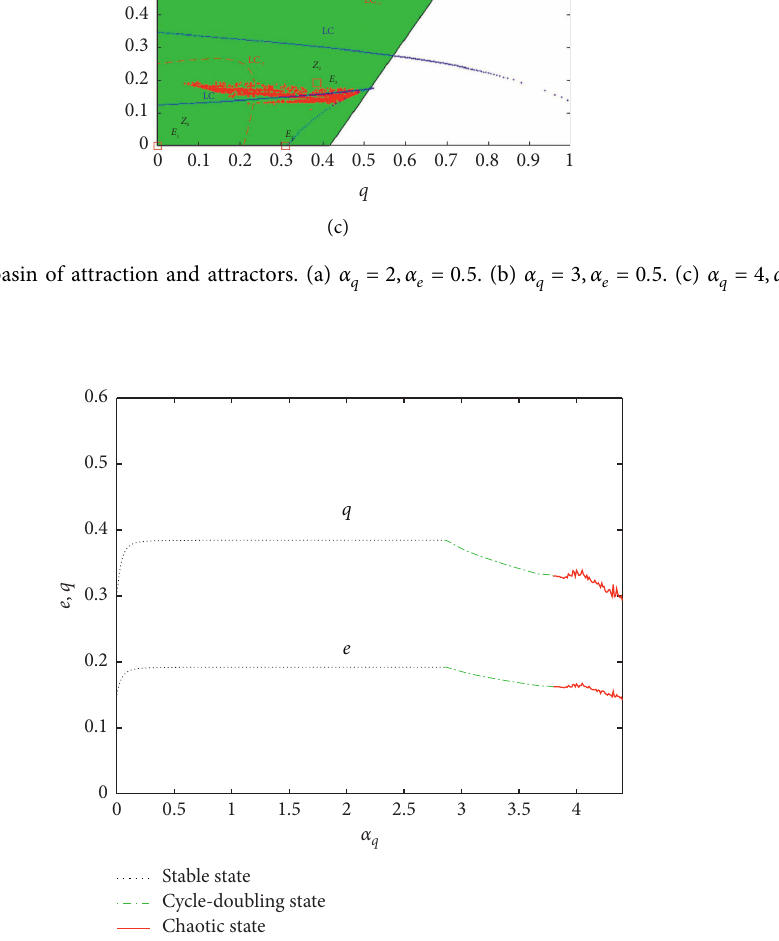
Figure 11: The average production quantity and eco-innovation effort of manufacturer in different states of system